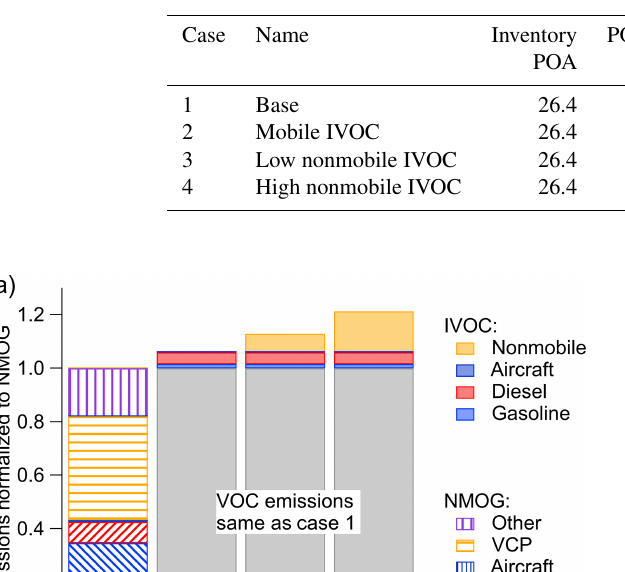
Table 4. Total anthropogenic organic emissions (Ton day − 1 ) in the Los Angeles Basin region in four CMAQ simulation cases.